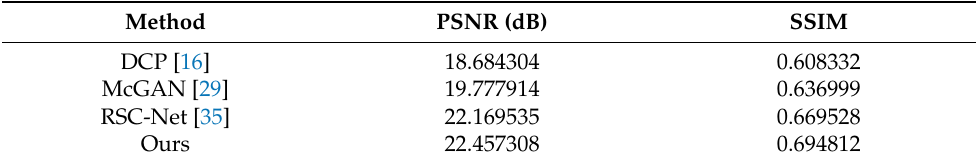
Table 8. Average PSNR and SSIM values of images reconstructed with various methods using the Sentinel-2A test set.